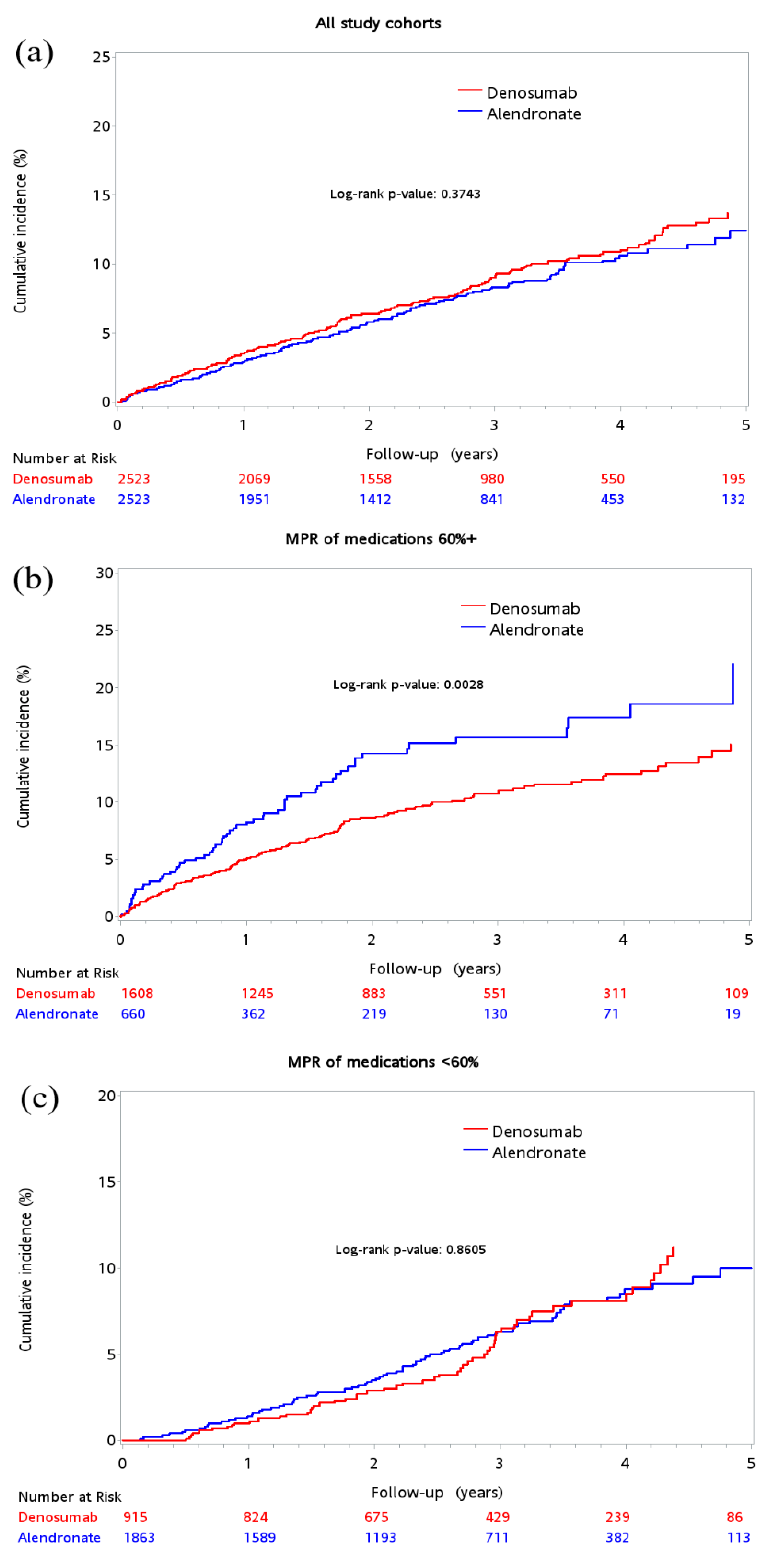
Figure 2. Cumulative incidence of composite cardiovascular outcomes between the denosumab and alendronate groups: All patients ( a ); patients with MPR ≥ 60% ( b ); patients with MPR < 60% ( c ); MPR: medication possession rate.